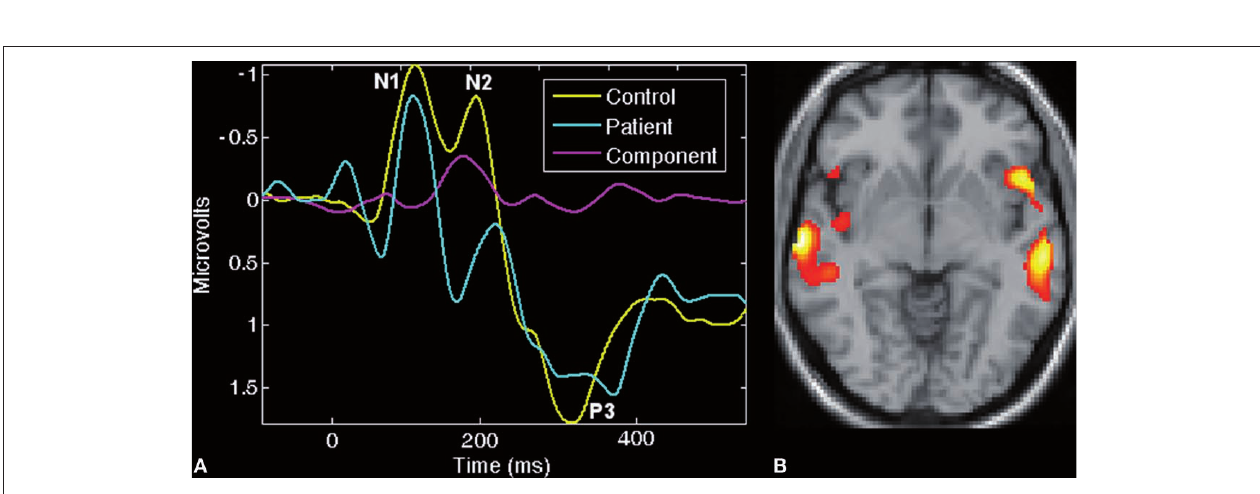
FIGURE 6 | ERP/fMRI jICA (from Calhoun and Adali, In Press). Joint component which showed signifi cantly different loading parameters ( p < 0.0001) for patients versus controls: (A) control (yellow) and patient (blue) average ERP plots along with the ERP part of the identifi ed joint component (pink). (B) Thresholded fMRI part of the joint component showing bilateral temporal and frontal lobe